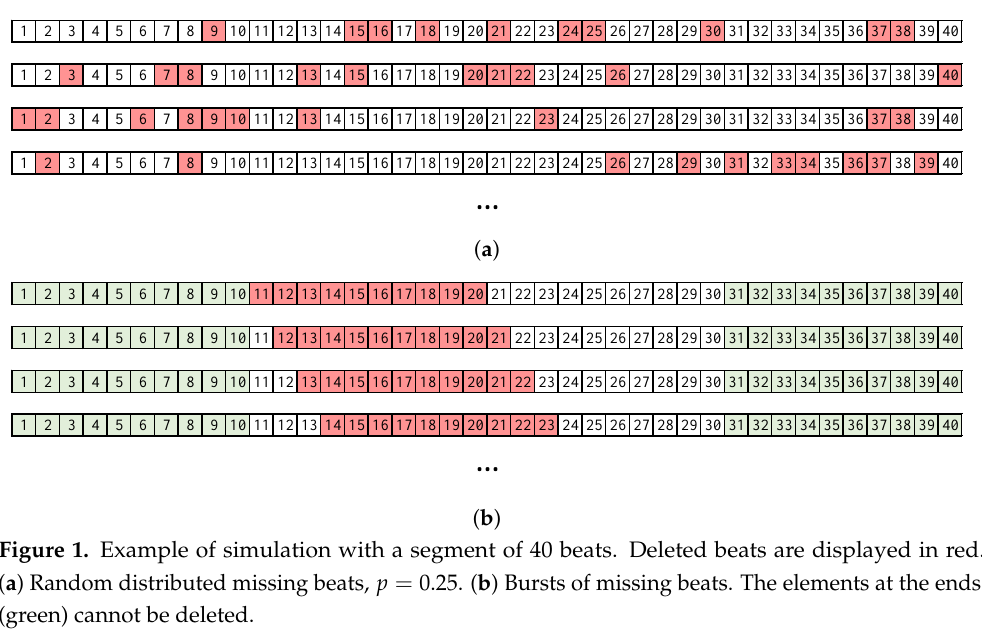
Figure 1. Example of simulation with a segment of 40 beats. Deleted beats are displayed in red. ( a ) Random distributed missing beats, p = 0.25. ( b ) Bursts of missing beats. The elements at the ends (green) cannot be